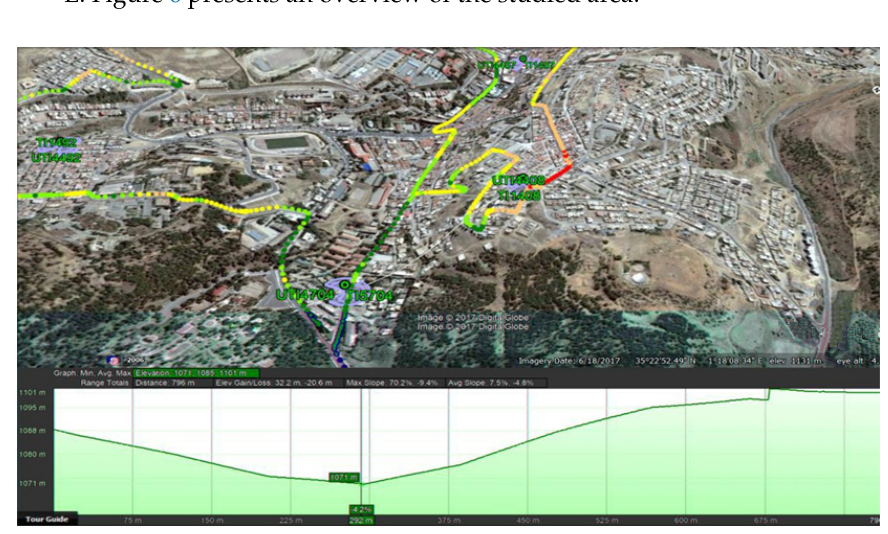
Figure 6. Studied area.